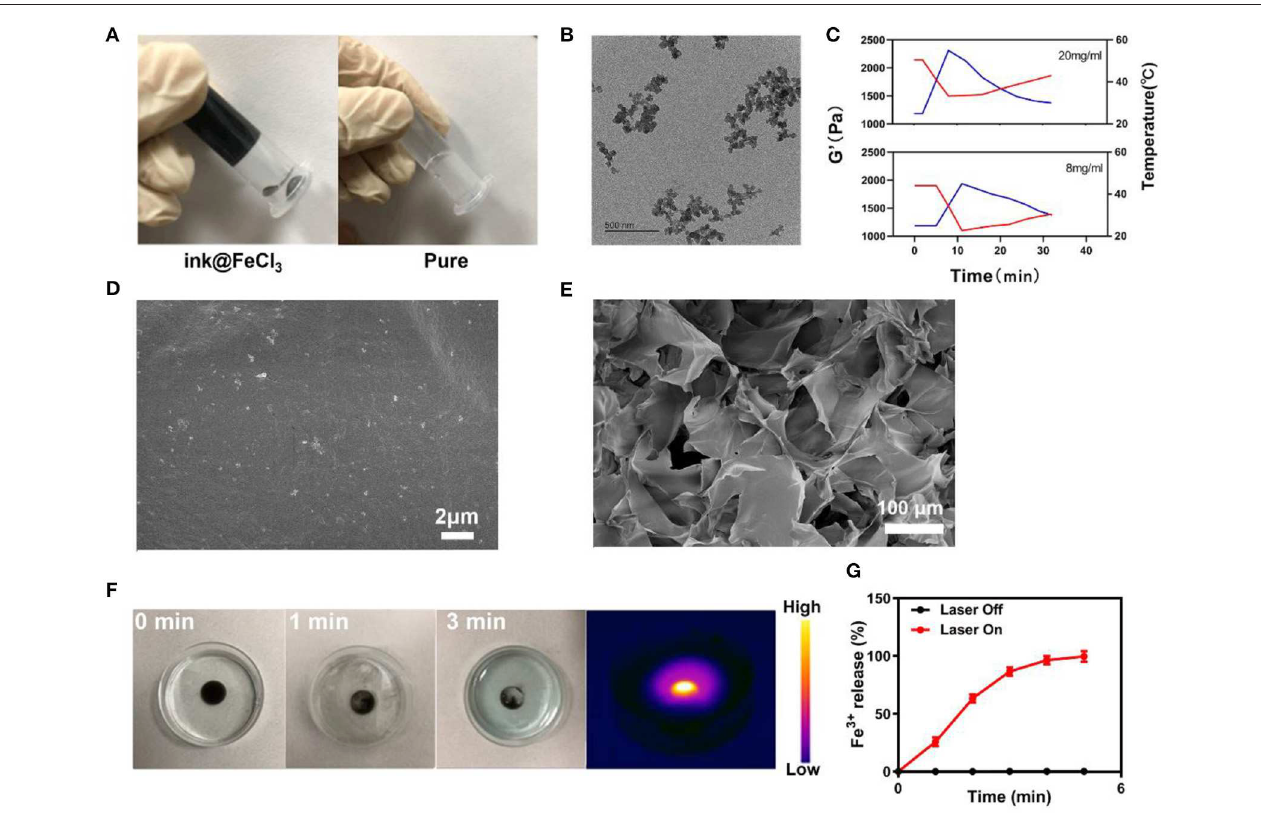
FIGURE 1 | (A) Various hydrogels prepared. (B) TEM image of the ink. (C) Rheological curve (red line) and corresponding temperature curve (blue line) of ink@hydrogel under NIR irradiation at 1 W/cm 2 . (D) SEM image of the ink@hydrogel. (E) SEM image of the ink@hydrogel at a lower magnification. (F) Hydrogel dissolved by the 1,064-nm laser irradiation (1 W/cm 2 ). (G) Release rate of Fe 3 + from the ink@hydrogel with (red) and without (black) laser